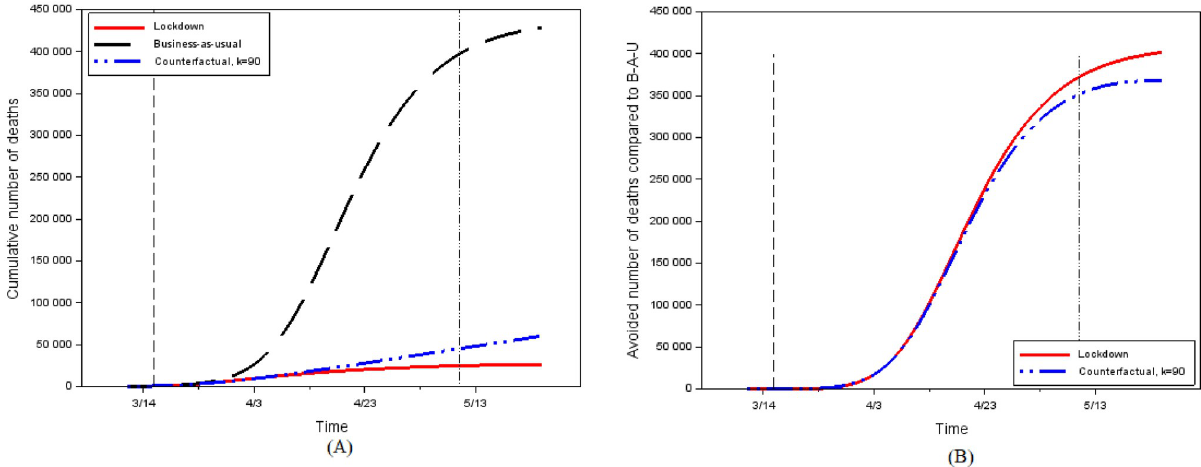
Fig 5. The impact of lockdown. (A) Cumulative number of deaths under various scenarios. (B) Avoided deaths compared to business-as-usual.